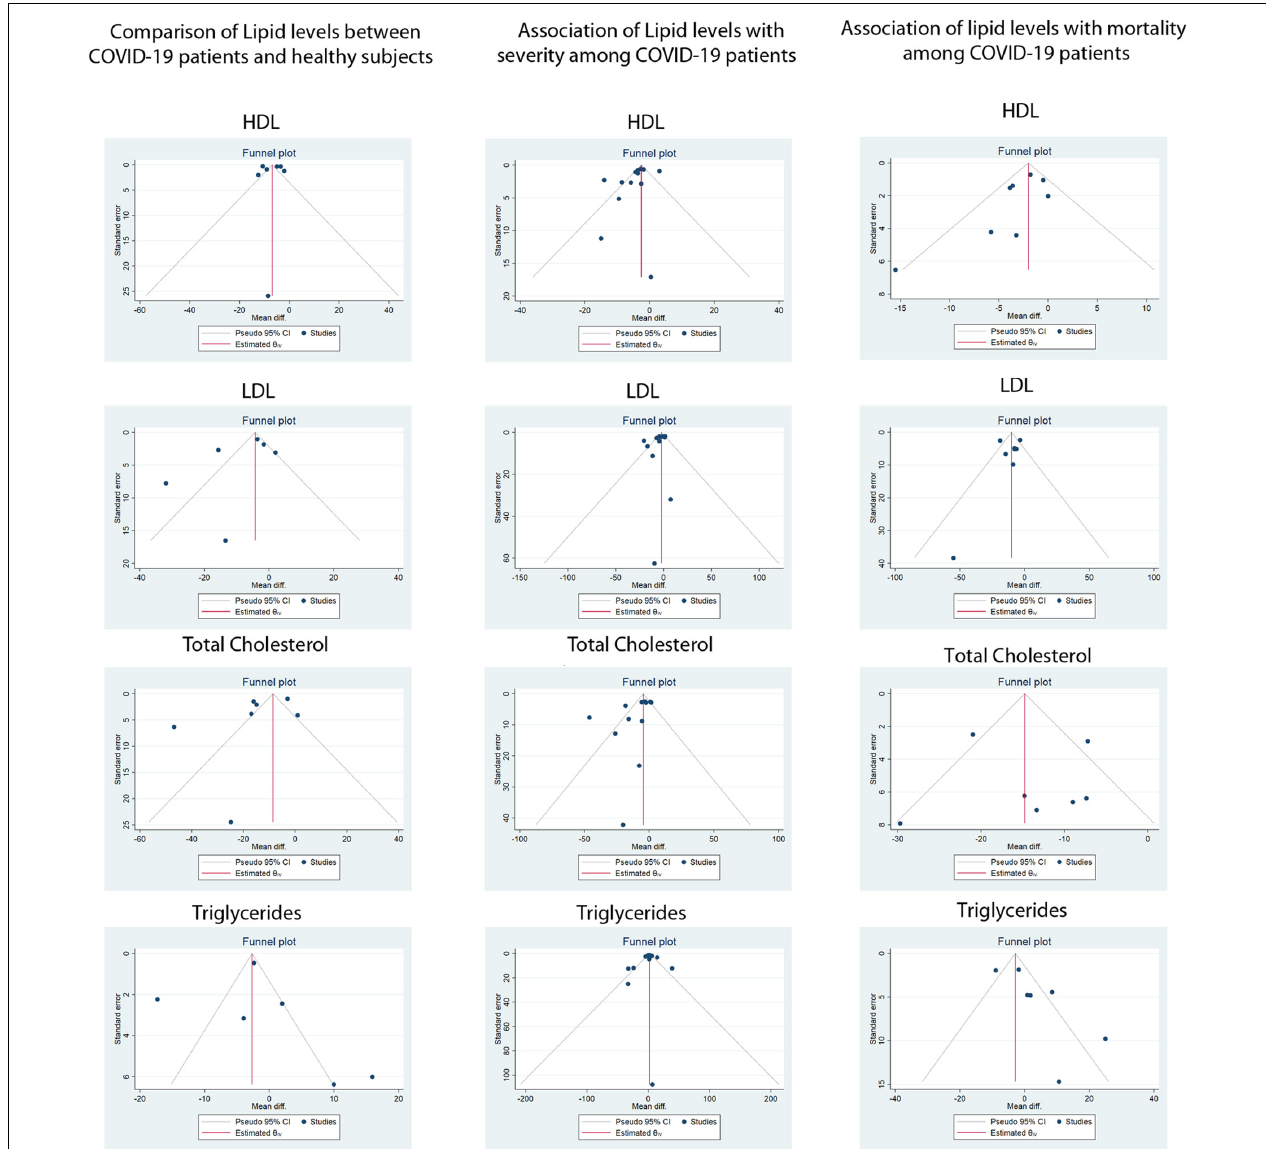
FIGURE 3 | Funnel plots for assessment of publication bias for the association of lipid levels with COVID-19 infection, disease severity and mortality. LDL-C, Low density Lipoprotein, HDL-C, High Density Lipoprotein.